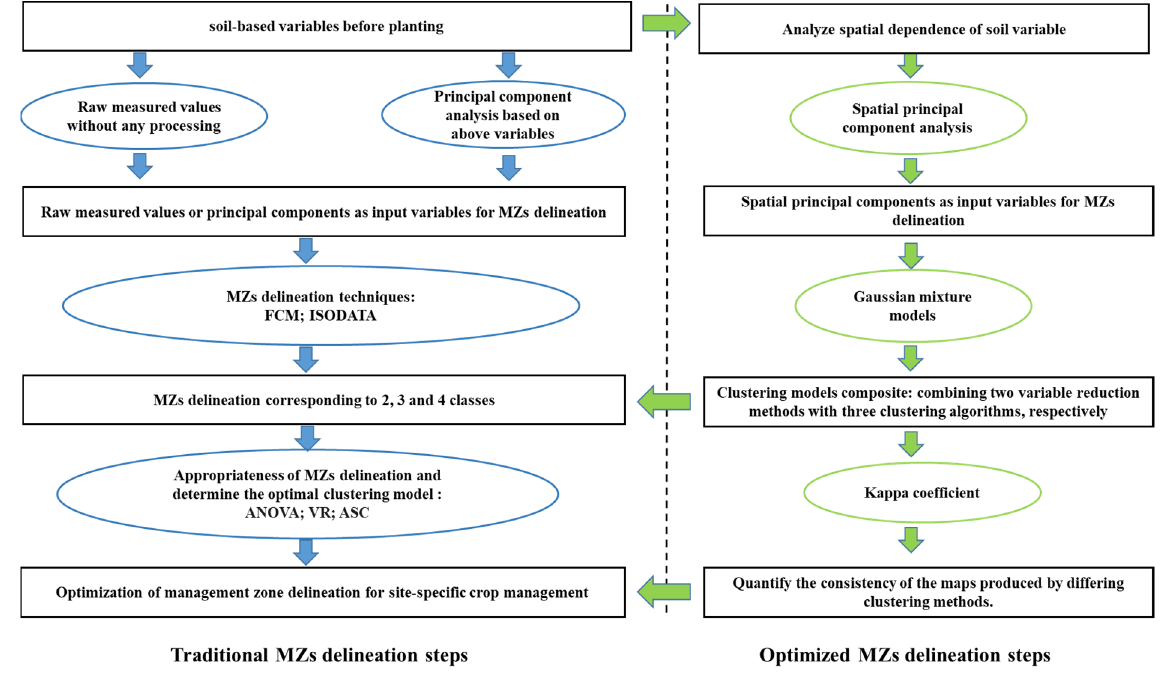
Figure 8. Flow chart of the optimized MZ delineation in this